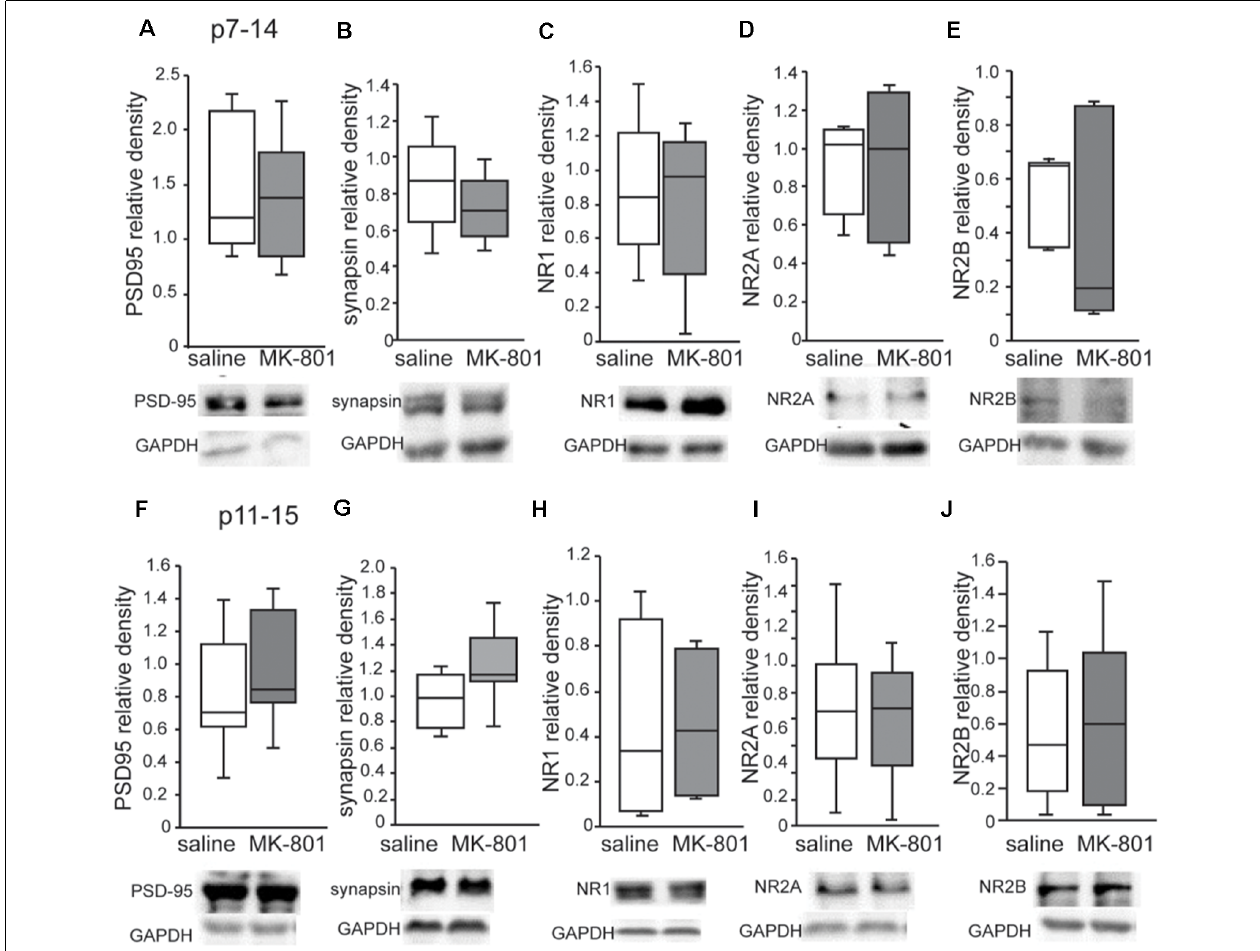
FIGURE 5 | Expression of PSD-95, synapsin, NR1, NR2A, and NR2B in the PFC of nMK-801(p7–14; n = 6) and nMK-801 (p11–15; n = 6) compared to their respective saline-treated controls ( n = 6 for each of the control group). (A) No differences are identified in the PSD95 relative density in the PFC of nMK-801 (p7–14) compared to saline-treated ( t -test, p = 0.8). (B) No differences are identified in the synapsin relative density in the PFC of nMK-801 (p7–14) compared to saline-treated ( t -test, p = 0.3). (C) No differences are identified in the NR1 relative density in the PFC of nMK-801 (p7–14) compared to saline-treated ( t -test, p = 0.8). (D) No differences are identified in the NR2A relative density in the PFC of nMK-801 (p7–14) compared to saline-treated ( t -test, p = 0.35). (E) No differences are identified in the NR2B relative density in the PFC of nMK-801 (p7–14) compared to saline-treated ( t -test, p = 0.35). (F) No differences are identified in the PSD95 relative density in the PFC of nMK-801 (p11–15) compared to saline-treated ( t -test, p = 0.4). (G) No differences are identified in the synapsin relative density in the PFC of nMK-801 (p11–15) compared to saline-treated ( t -test, p = 0.15). (H) No differences are identified in the NR1 relative density in the PFC of nMK-801 (p11–15) compared to saline-treated ( t -test, p = 0.9). (I) No differences are identified in the NR2A relative density in the PFC of nMK-801 (p11–15) compared to saline-treated ( t -test, p = 0.8). (J) No differences are identified in the NR2B relative density in the PFC of nMK-801 (p11–15) compared to saline-treated ( t -test, p = 0.9).